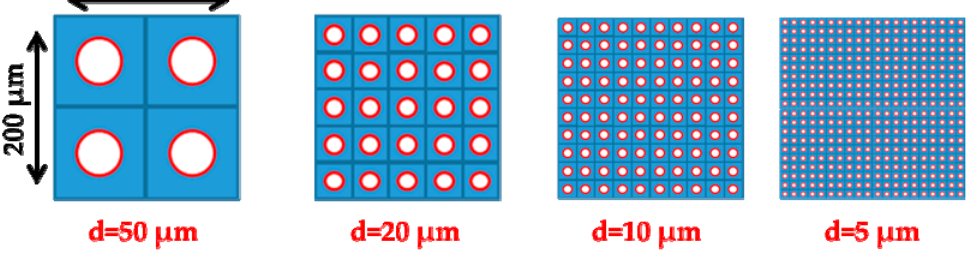
Figure 3. View of layouts with increasing the number n of microchannels and decreasing the channel diameter d , keeping the same ratio between the channels and the overall cross sections. Table 1. Layout data in terms of diameter, number of microchannels, and elementary square area.